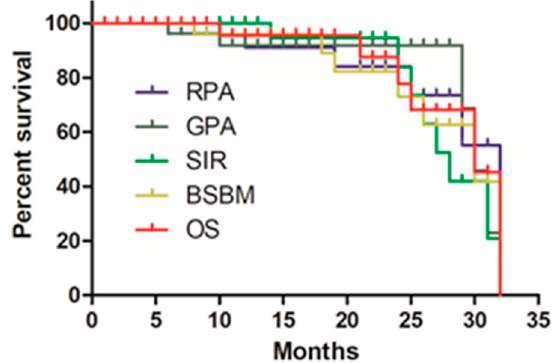
Figure 1. Overall survival curve for the four Prognostic Indices. RPA, Recursive Partitioning Analysis; GPA, Graded Prognostic Assessment; SIR, Score Index for Radiosurgery; BSBM, Basic Score for Brain Metastases; and OS, overall survival curve for all patients.